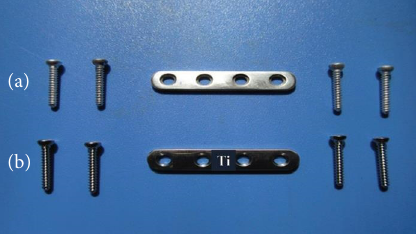
F IGURE 1: Photographs of (a) the magnesium alloy plate and (b) the titanium alloy